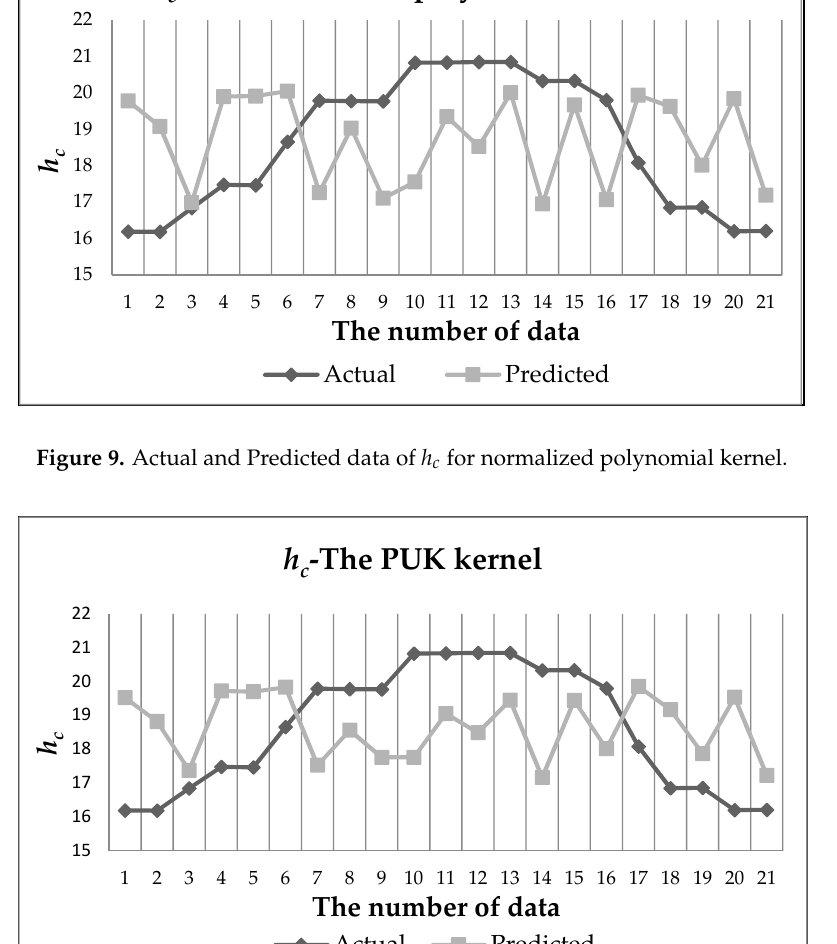
Figure 11. Actual and Predicted data of h c for radial basis function (RBF) kernel. In the AHSC drying system, hot air sent to the drying cab is provided by the solar panel. Hot air from the panel is sent to the drying cab with the aid of a radial fan. In Table 3, the temperature of the air passing through the panel changes according to the solar radiation values on the solar panel. If